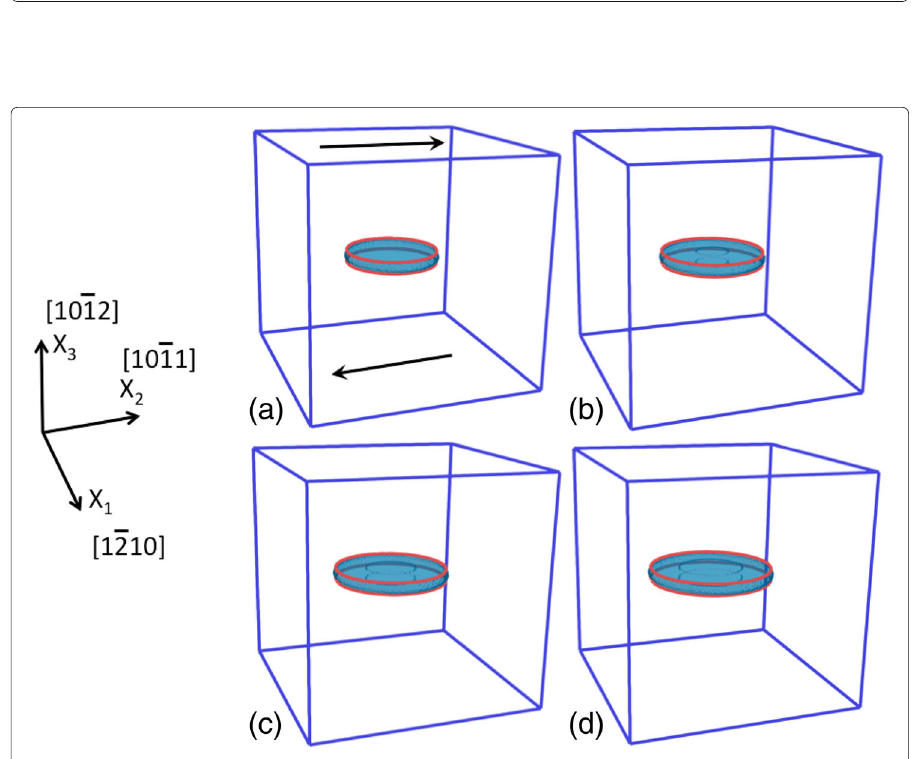
Fig. 6 Growth in the transverse direction of a ( 10 ¯ 12 ) twin. The twin is modelled by a dipole of disclination loops (red solid lines) and gowth as per application of a shear strain (cid:4) 23 of 0.01. From ( a ) to ( d ): progressive growth of the twin. The arrows show the applied shear in figure ( a ). In blue colour is shown the plastic rotation around X 1 . Only plastic rotation values smaller than -0.06 rad are